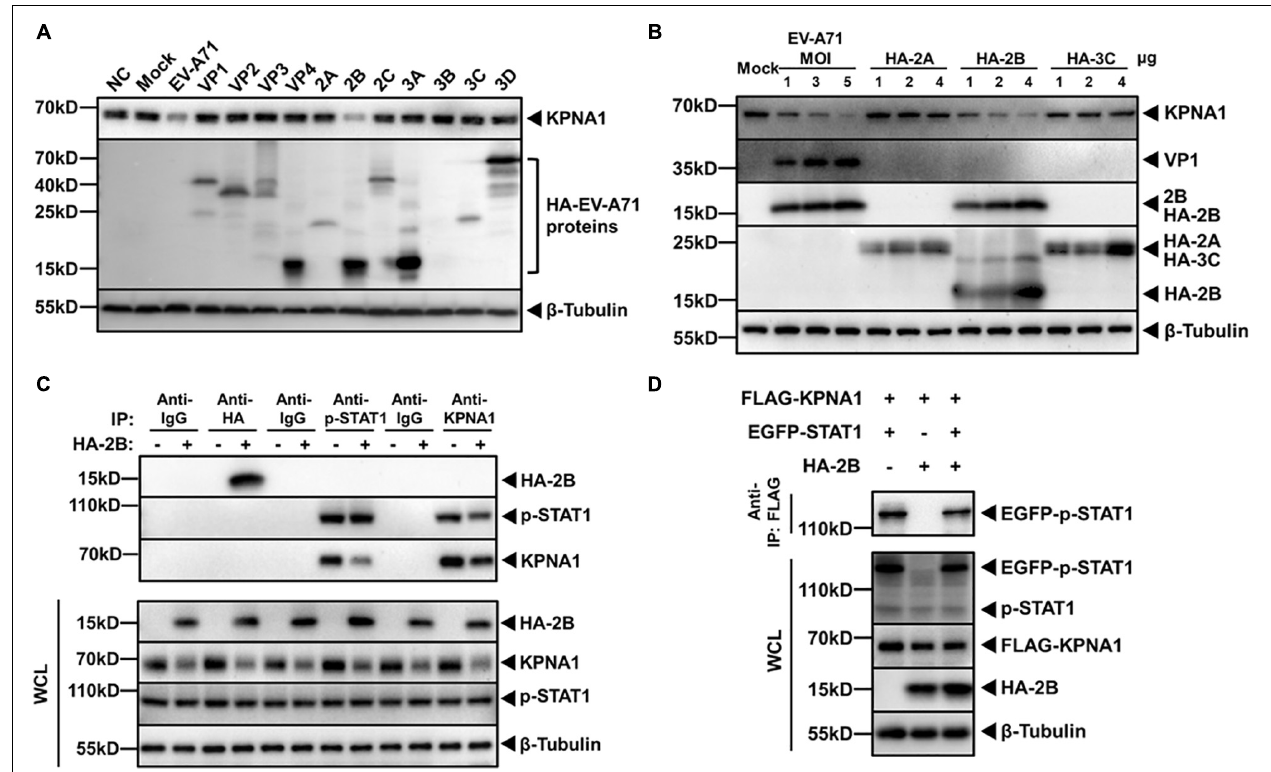
FIGURE 2 | EV-A71 2B reduced levels of KPNA1 and p-STAT1/KPNA1 complex. (A) Reduction of KPNA1 levels by EV-A71 viral proteins. HeLa cells were infected with EV-A71 at an MOI of 1 or transfected with plasmids (2.0 µ g) expressing HA-tagged viral proteins. Cell lysates were prepared for western blot analyses with antibodies for HA tag or KPNA1. (B) Reduction of KPNA1 levels by viral 2A, 2B, and 3C. HeLa cells were infected with EV-A71 or transfected with plasmids expressing HA-tagged 2A, 2B, or 3C. Cell lysates were prepared for western blot analyses with antibodies for HA tag and KPNA1. (C) Reduction in levels of the p-STAT1 and KPNA1 complex in IFN- α -stimulated cells by 2B. HeLa cells were transfected with plasmids expressing HA-tagged 2B (2.0 µ g). At 36 h post transfection, the cells were treated with IFN- α (25 ng/ µ L) for 2 h. Cell lysates were prepared for co-immunoprecipitation (Co-IP) with antibodies for HA, p-STAT1, or KPNA1. Normal isotype IgG was used as negative control. Subsequent western blot analyses were performed with antibodies for HA, p-STAT1, or KPNA1. The levels of inputs in the whole cell lysates (WCL) were also shown together with β -Tubulin. (D) EV-A71 2B reduced the levels of the exogenous p-STAT1 and KPNA1 complex. HeLa cells were transfected with plasmids expressing FLAG-KPNA1 (2.0 µ g), EGFP-STAT1 (2.0 µ g), and HA-2B (2.0 µ g). At 36 h post transfection, the cells were treated with IFN- α (25 ng/ µ L) for 2 h. Cell lysates were prepared for Co-IP with an anti-FLAG antibody and subsequent western blot analyses with antibodies for EGFP tag. The levels of inputs in WCL were also shown with antibodies specific for FLAG, EGFP, or HA